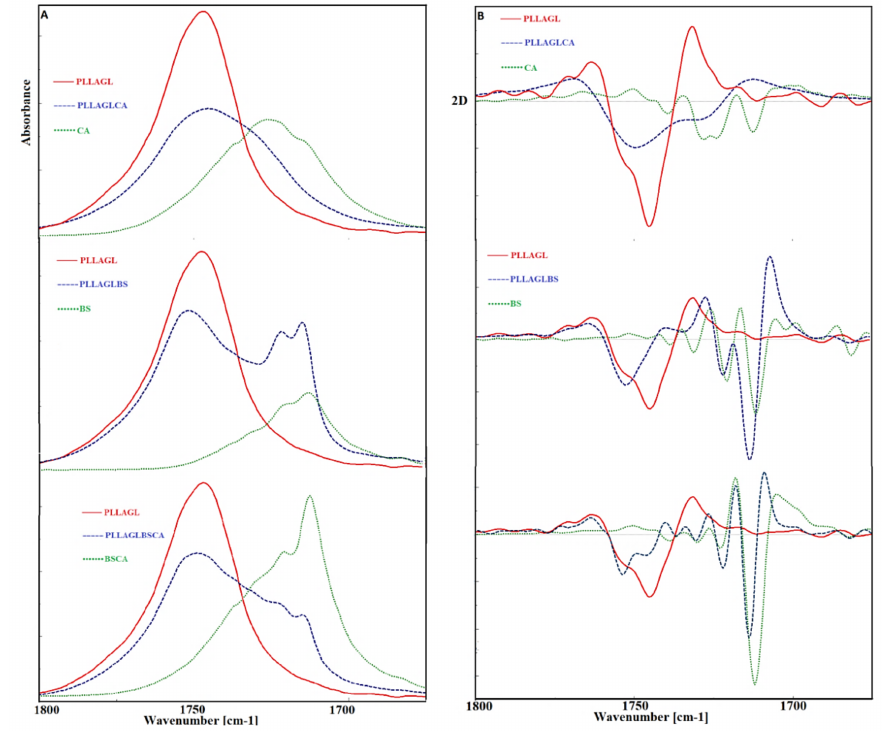
Figure 8. FTIR spectra of PLLAGL, oligomers, and blends ( A ) and their second derivatives spectra ( B